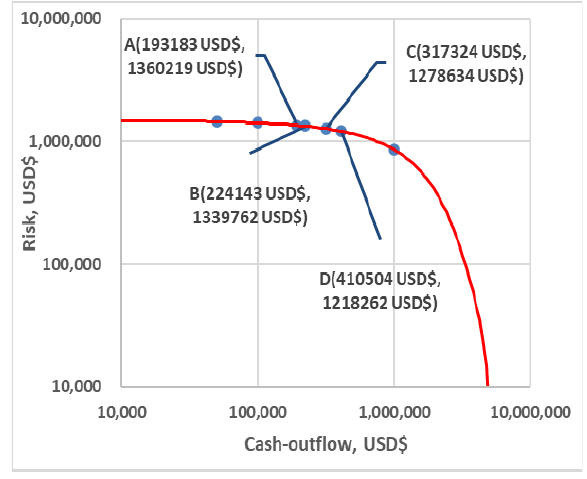
Figure 7. Financial risk as a function of cash-outflow.